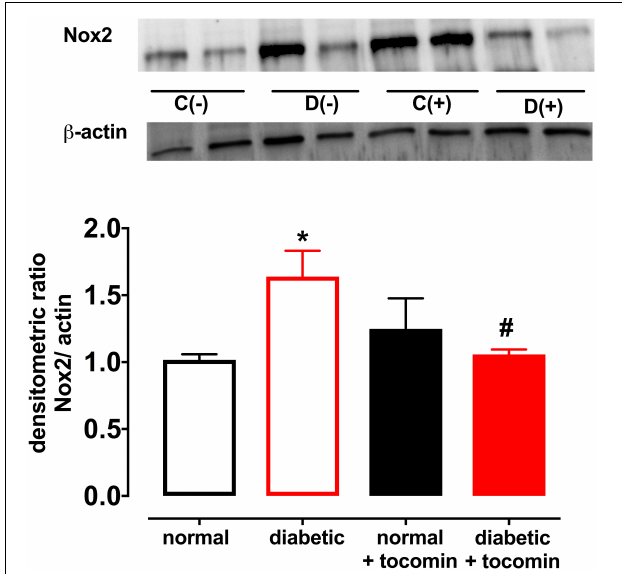
FIGURE 4 | Protein expression of NADPH oxidase (Nox2) from isolated aortae from normal, diabetic, and tocomin treated (normal + tocomin/diabetic + tocomin) rats. Representative blots are shown for each corresponding graph. ∗ Significantly different to normal. # Significantly different to diabetic. Results are shown as means ± SEM. P < 0.05. Two-way ANOVA Dunnett’s multiple comparison test. n = 3–5